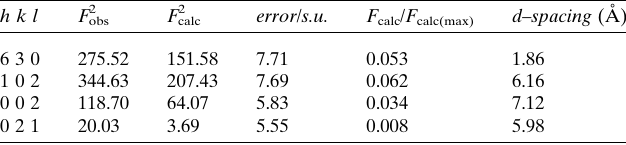
Table 3 List of the top four poorly fitting reflections for the model of the mixed mono/di-selenide shown in Fig. 4.